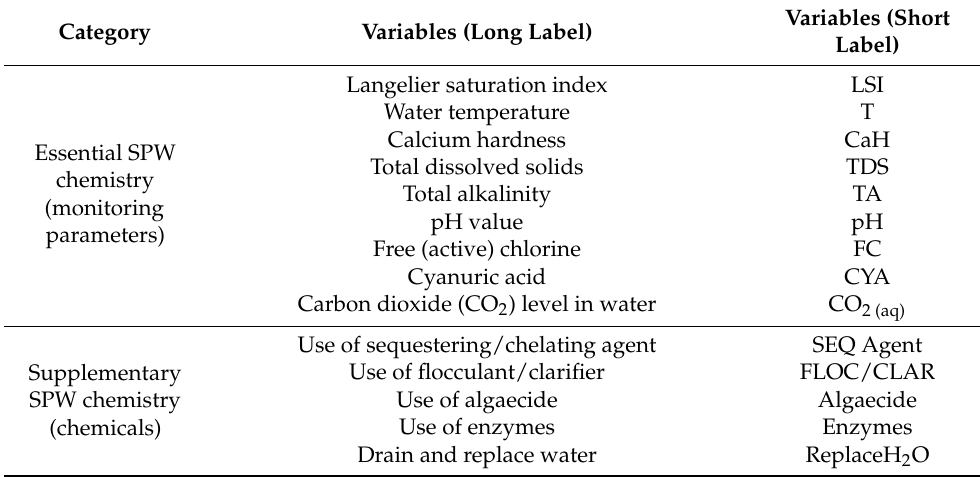
Table 1. List of variables used in the MICMAC